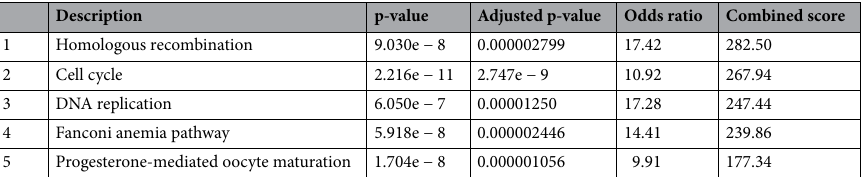
Table 6. KEGG pathway based enrichment analysis of up-regulated